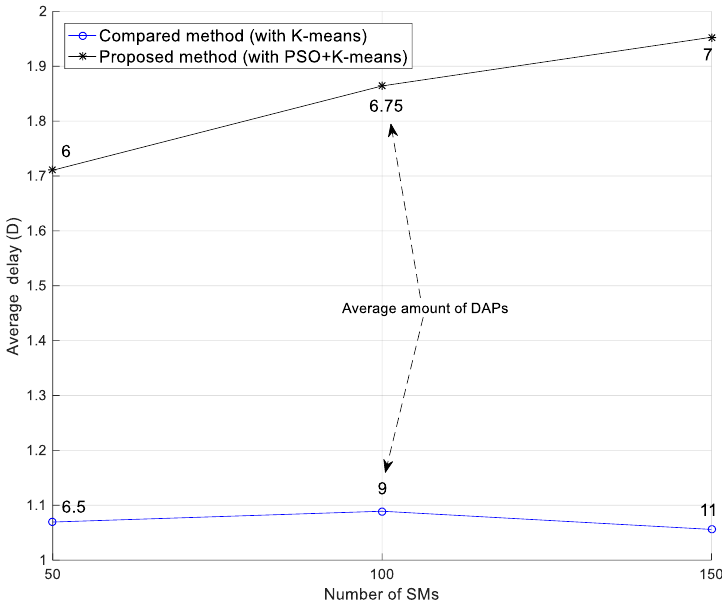
Figure 11. The comparison of delay in different numbers of SMs.